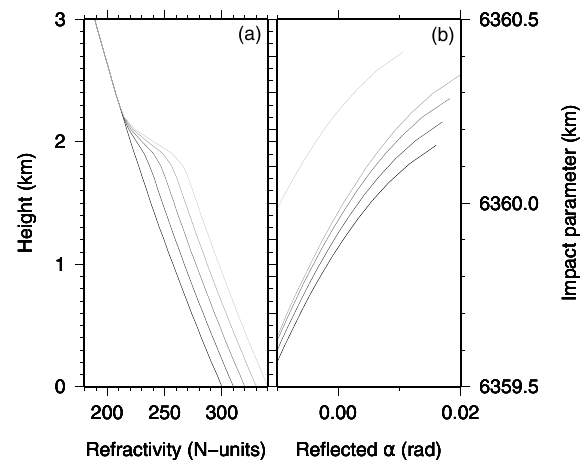
Figure 12. Synthetic case to demonstrate sensitivity of reflection under ducting. Panel (a) shows a family of synthetic atmospheric re- fractivity profiles, generated as an exponential function, with a more refractive lower troposphere. The transition is modelled as an error- function. The transition to this extra refraction is very steep, which is common in superrefractive or ducting layers. Panel (b) shows the corresponding series of reflected bending and impact parame- ters (see Fig. 10b for a case with real data), as evaluated by Eq. (3), and indicates that the profile of reflected bending is sensitive to the refractivity step across the